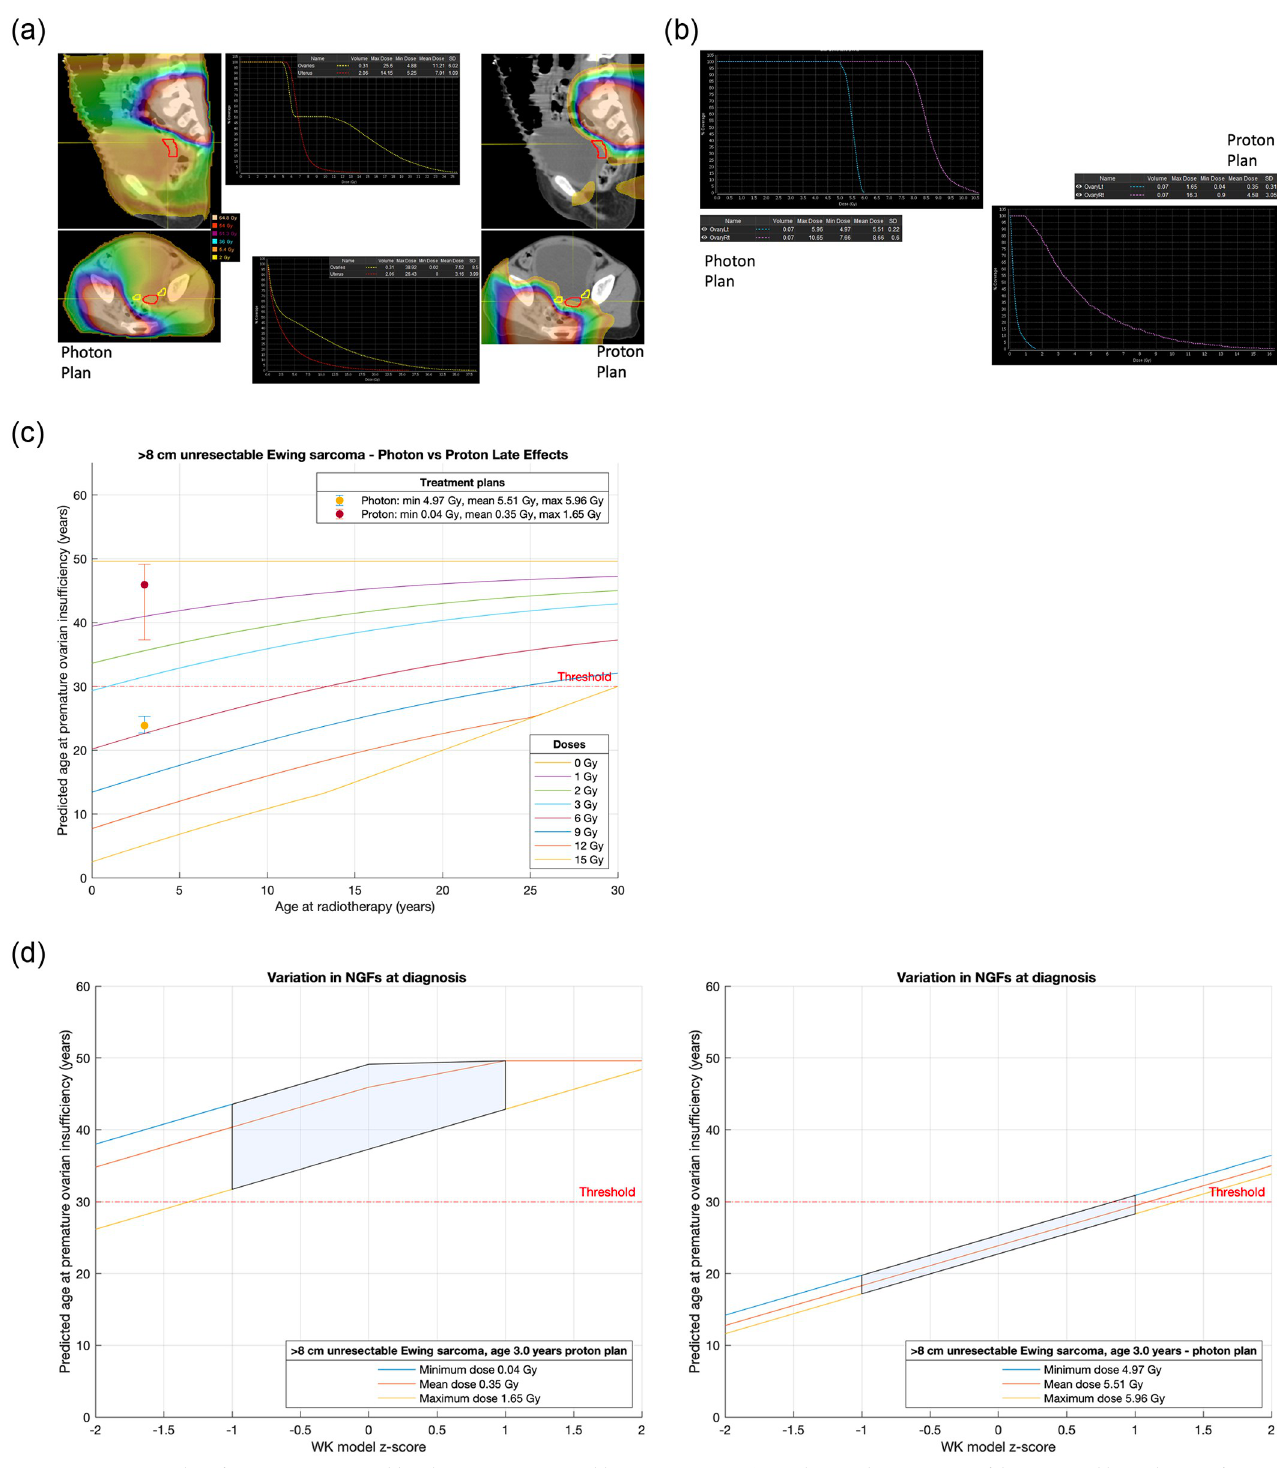
Fig 7. a . Treatment plans for Case 4, a 3-year-old with a > 8 cm unresectable Ewing sarcoma. b . Analysis and comparison of dose received by each ovary for Case 4, a 3-year-old with a > 8 cm unresectable Ewing sarcoma. c . Comparison of treatment plans assuming average NGF population at age of treatment (i.e., z- score = 0) for Case 4, a 3-year-old with a > 8 cm unresectable Ewing sarcoma. Dots are predicted age at menopause after mean dose. Fertility window ranges between predicted ages for minimum & maximum dose. LD 50 is estimated to be 2 Gy. Dose is to the least affected ovary. d . Comparison of treatment plans for Case 4, a 3-year-old with a > 8 cm unresectable Ewing sarcoma that incorporate uncertainty due to variation in NGF population at birth. (Or, equivalently,